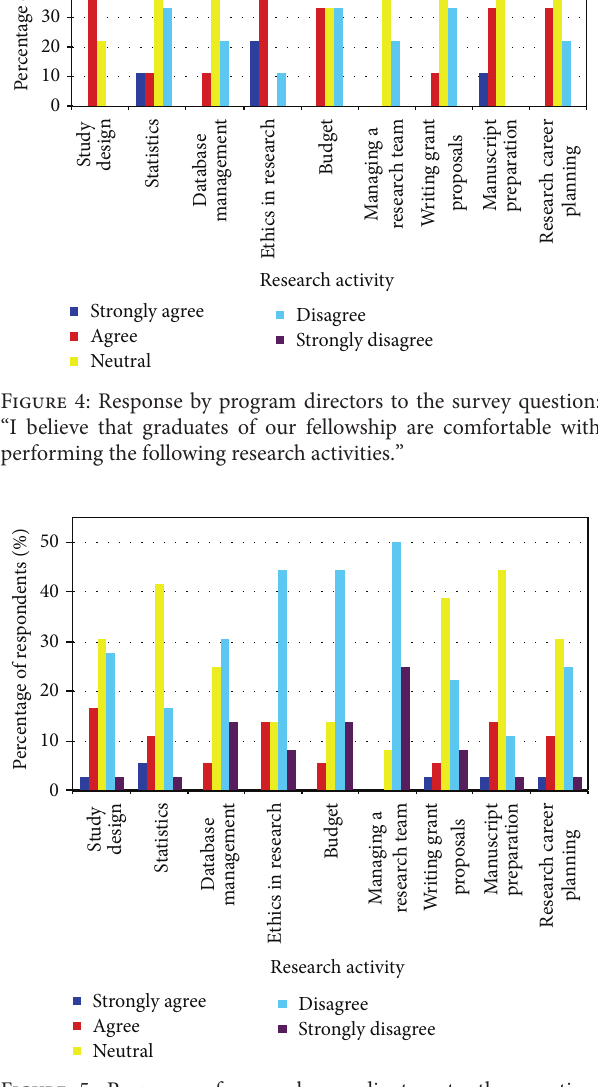
Figure 5: Response of research coordinators to the question: “Within my institution, Critical Care fellows and junior faculty members are well trained in the following areas of